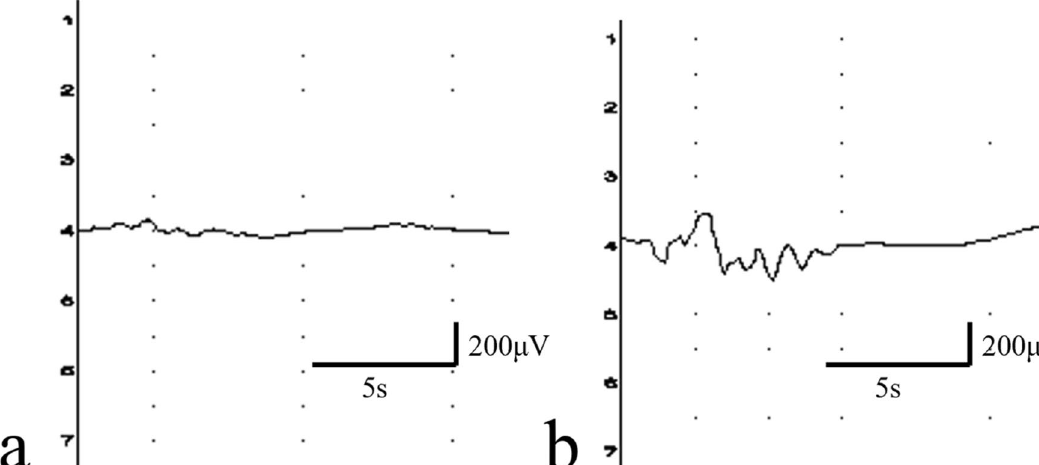
Figure 3. The waveforms of transcranial electrical stimulated motor-evoked potentials (tcMEPs) recorded using a previous technique ( a ) No tcMEPs were derived. ( b ) Only unstable waveforms were